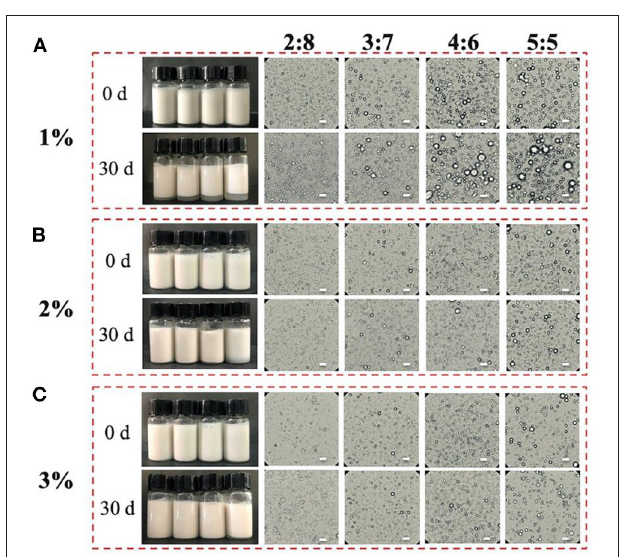
FIGURE 2 | Visual appearance and microstructures of the proteins-stabilized emulsions with different concentrations (A–C) at initial (0 days) and after 30 days of quiescent storage. Scale bar = 5 µ